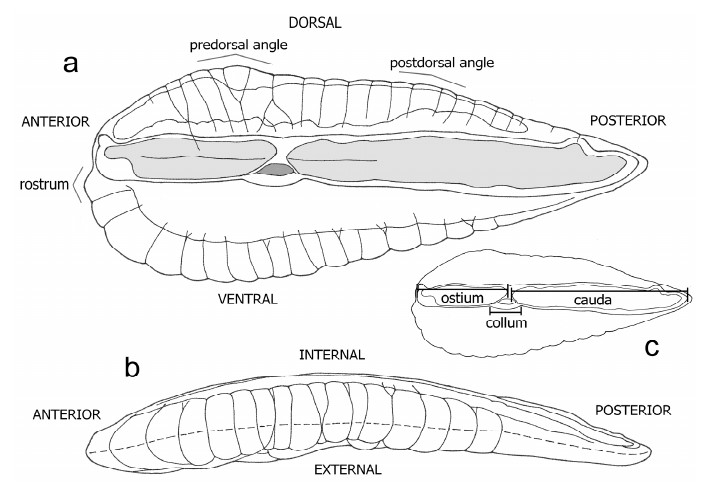
Figure 1. Left otolith of † Colliolus mistensis Gaemers, 1990. ( a ) Inner surface showing length and height (or width) of the otolith; the colliculi are light grey, the medially situated pseudocolliculum is dark grey; the ventral margin is regularly bent, the dorsal margin has a distinct predorsal angle and a weak postdorsal angle; ( b ) Ventral view showing length, thickness and lengthwise curvature of the otolith; ( c ) Overview with ostium, cauda and collum.